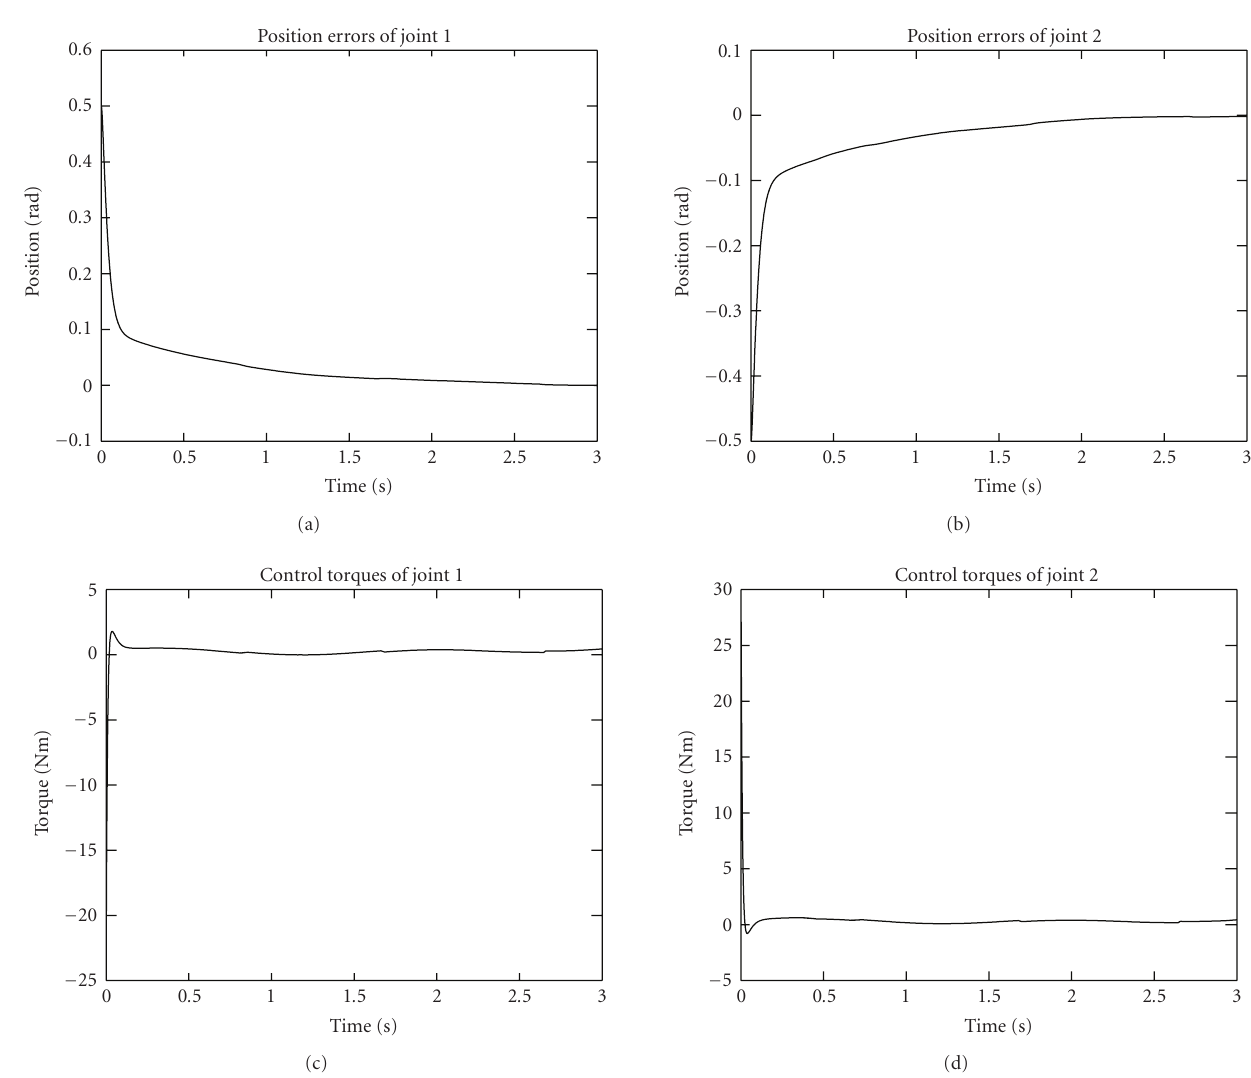
Figure 5: Response using proposed intelligent robust control law ( α = 100, η = 0 .